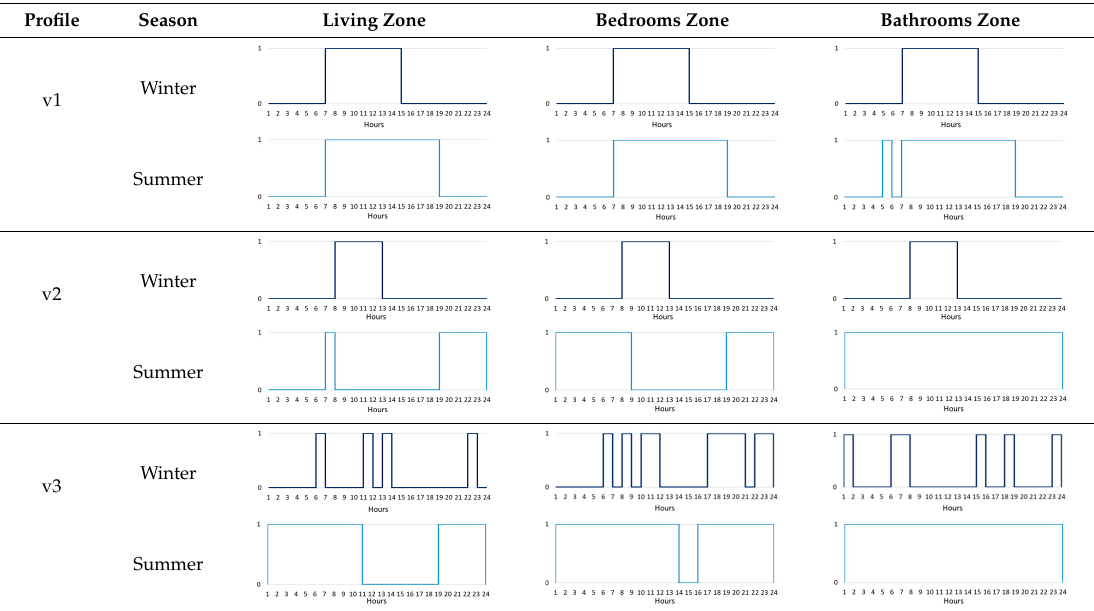
Table 4. Daily Natural ventilation schedules (Open = 1, Close = 0).